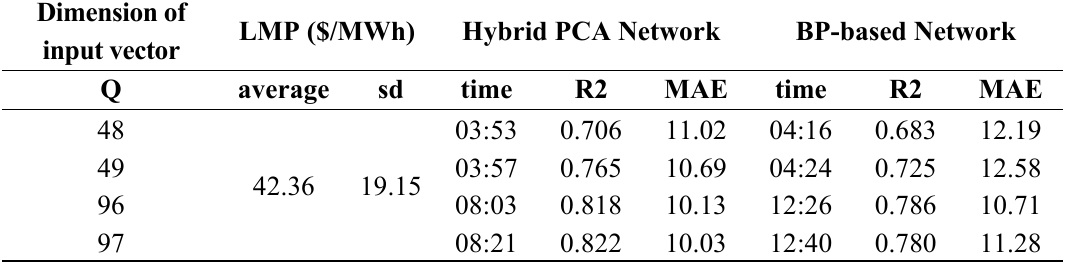
Table 4. Performance comparison between the proposed hybrid PCA and BP-based neural network (Fisk,